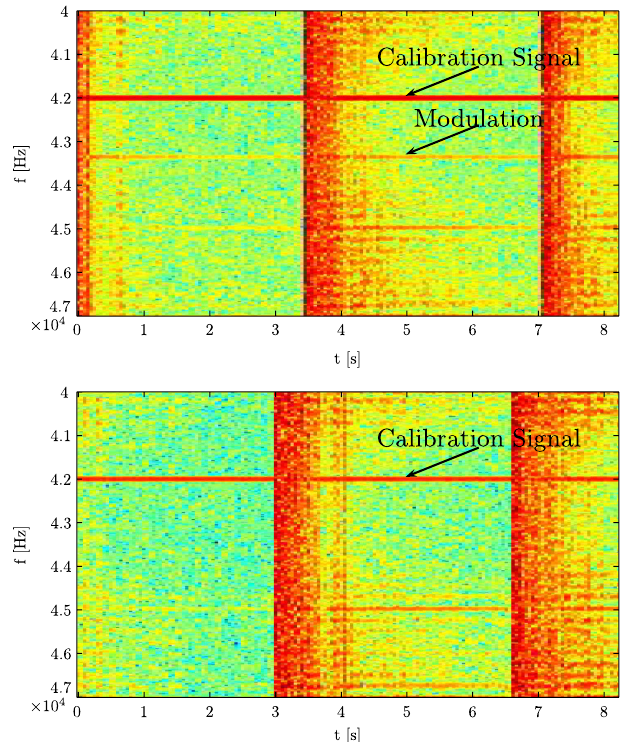
FIG. 6. Spectrum after phase demodulation. The calibration line can be seen in the coated as well as in the uncoated section whereas the genuine modulation line at around 43 kHz can only be seen in the uncoated case. The data were taken with the nominal LHC 25 ns beam of four batches at SPS flat bottom.